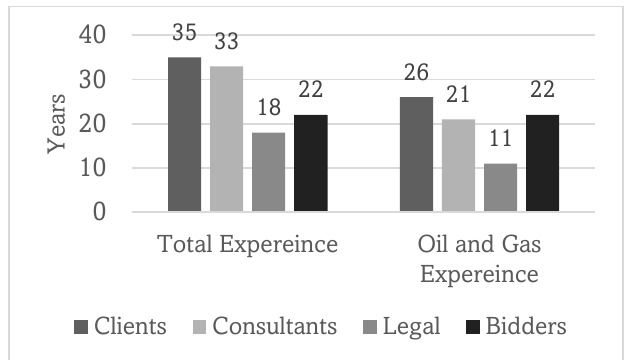
Fig. 3 . Experience of focus